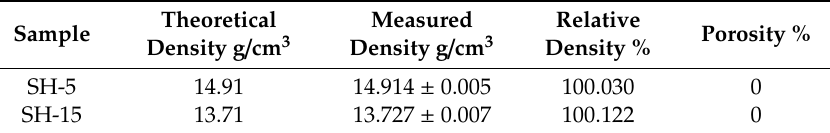
Table 5. Sintered samples density.